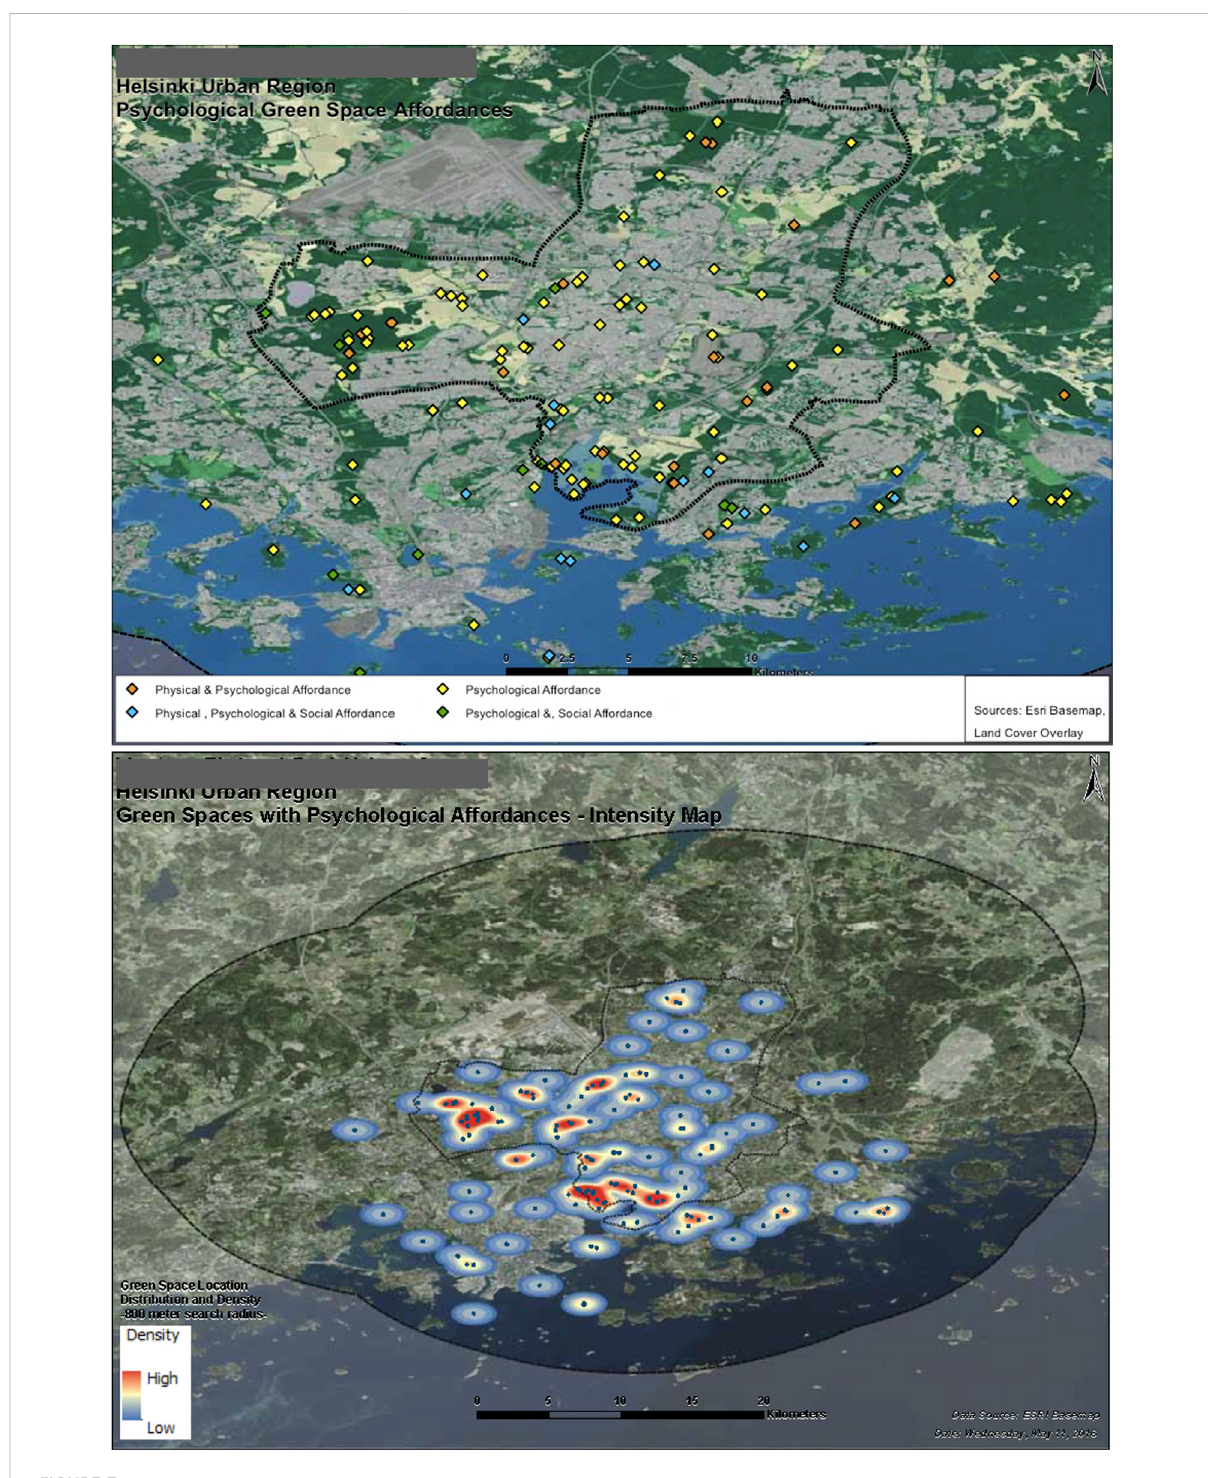
FIGURE 7 Physical human wellbeing affordance locations and intensity map. Source: